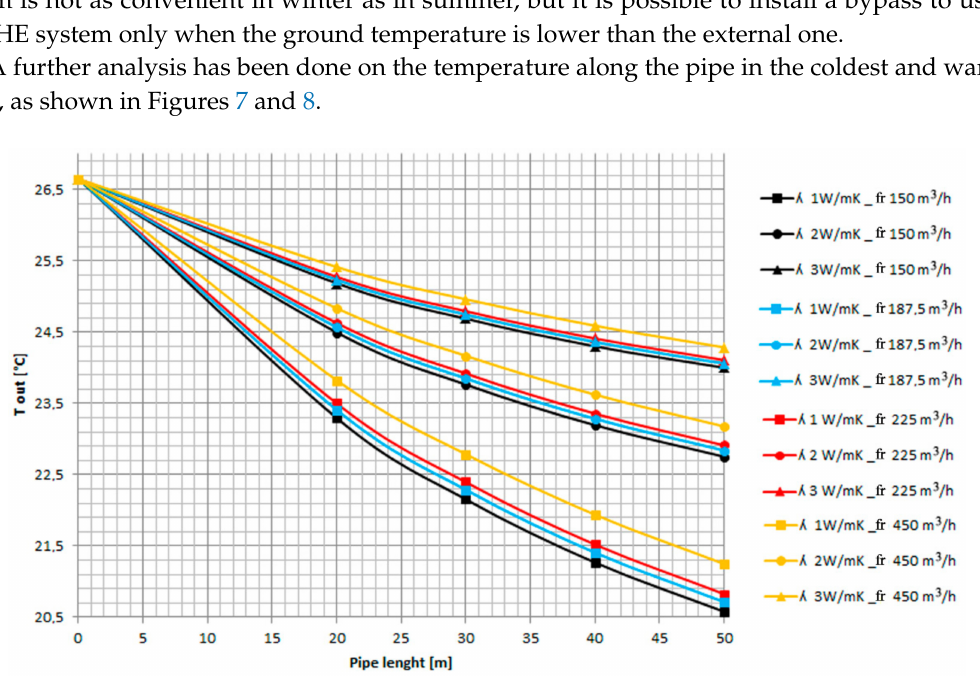
Figure 7. Air temperature along the pipe in the warmest hour (20 July, at hour 15).